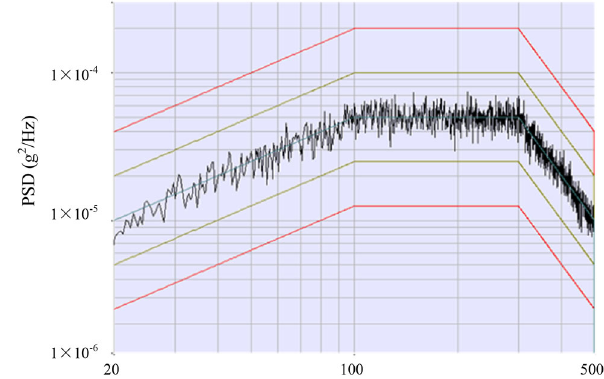
Fig. 8 Random vibration control curve